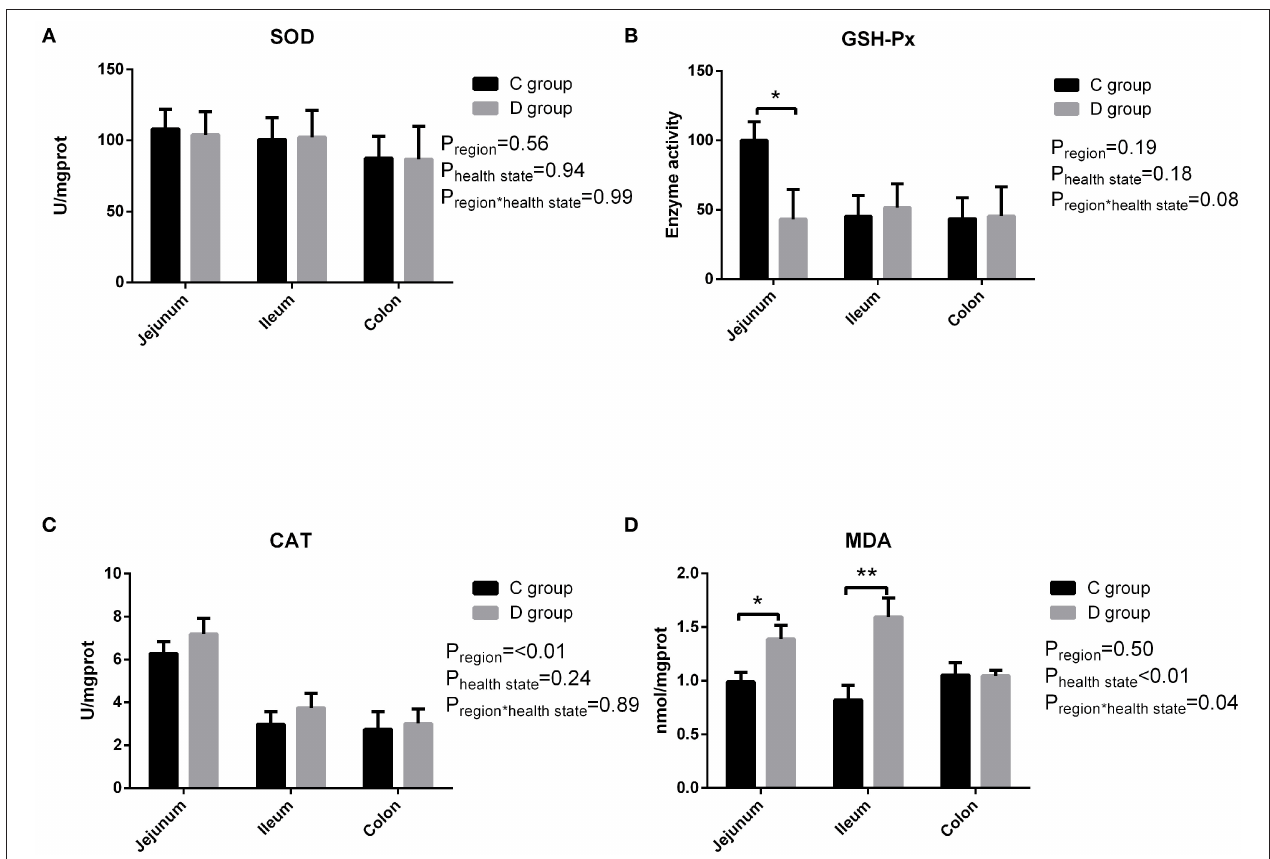
FIGURE 1 | The changes of intestinal SOD (A) , GSH-Px (B) , CAT (C) , and MDA (D) in neonatal diarrhea goats. C group means control group; D group means diarrhea group. Results are expressed as means ± standard error, significance was observed at * P < 0.05 and ** P <